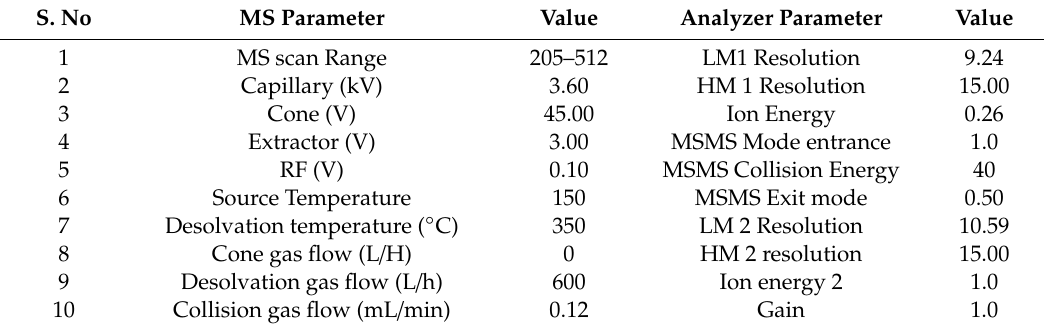
Table 1. MS parameters for determination of methylene blue, rhodamine B and crystal violet.